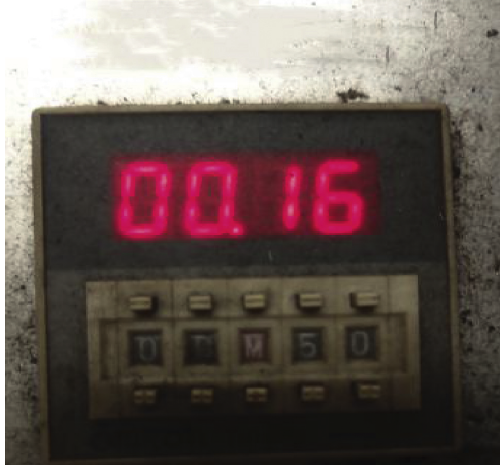
Figure 10: Setting dwell time.